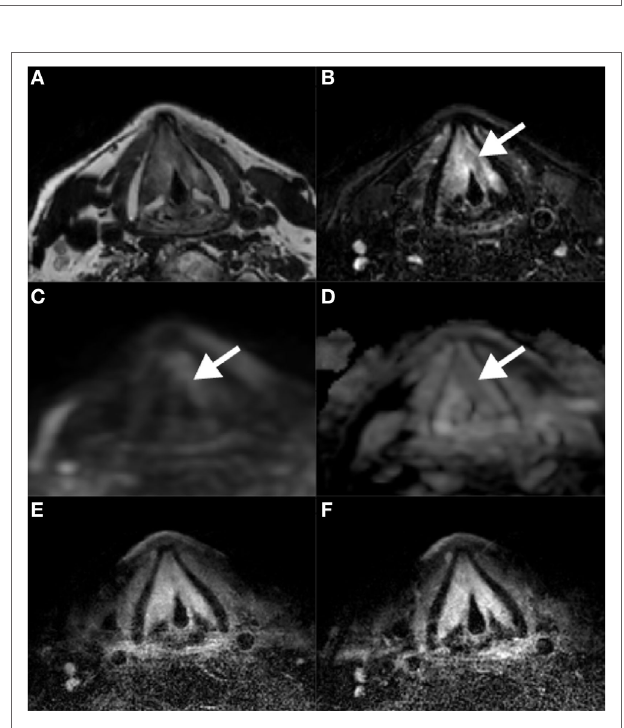
FIgURe 6 | Magnetic resonance imaging scans 8 months after radiation therapy for a T1b glottis carcinoma. Increased signal intensity on T2- weighted scans without (A) and with (B) fat suppression in both vocal cords, together with the absence of diffusion restriction on DWI/ADC (c,D) is compatible with posttreatment edema. A biopsy in the superficial area corresponding to intermediate signal on T2 and diffusion restriction on the left vocal cord revealed tumor recurrence. Contrast-enhanced T1-weighted scans at two different time points show gradual enhancement (e,F)